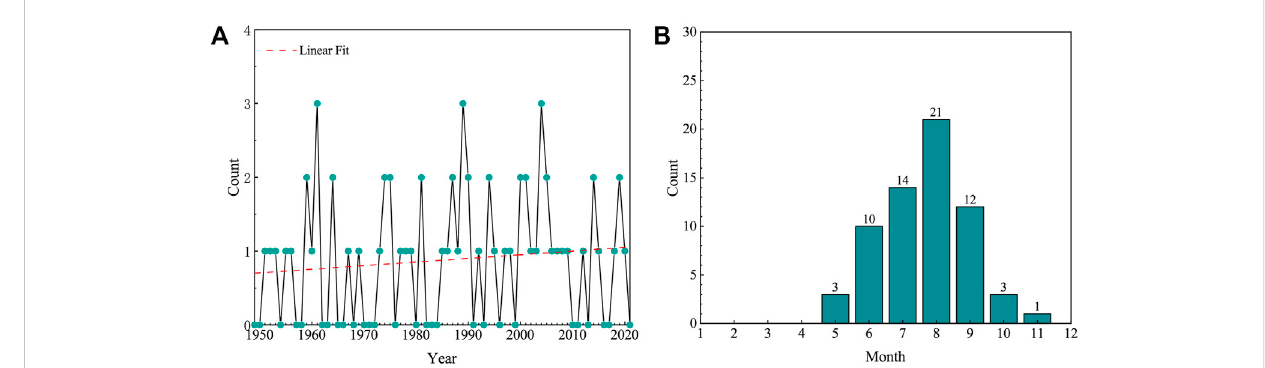
Locations and wind speed distributions for (A) all tropical cyclones and those moving (B) northward, (C) northwestward, and (D) northeastward and affecting the Donghaitang wind farm area during 1949 – 2021. Black dotted circle indicates the 150 km research area around the wind farm. The bubble distribution shows the center location of each tropical cyclone when it caused the maximum wind speed in the area of the Donghaitang wind farm; differentcolorsrepresentdifferentwindspeedscausedbythetropicalcyclonesinthewindfarmarea,andlargerbubblediametersindicateagreater maximum wind speed of the tropical cyclone. The red star marks the location of the Donghaitang wind